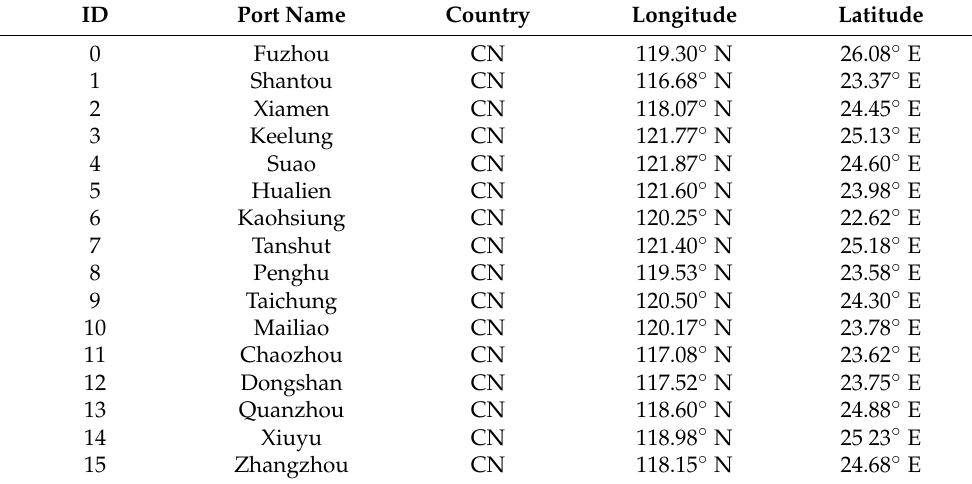
Table 2. Ports in the study